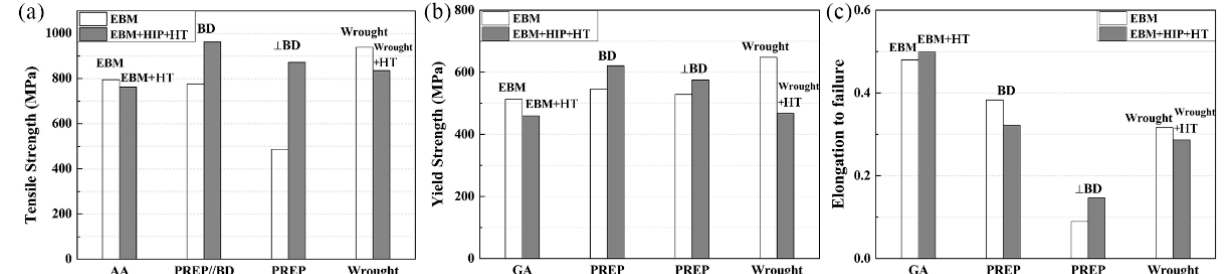
Figure 11. ( a ) Tensile strength, ( b ) yield strength, and ( c ) elongation to failure of GAed and PREPed GH4099 sample in different conditions cut parallel or/and perpendicular to building direction, as compared with that of a wrought sample along building direction.